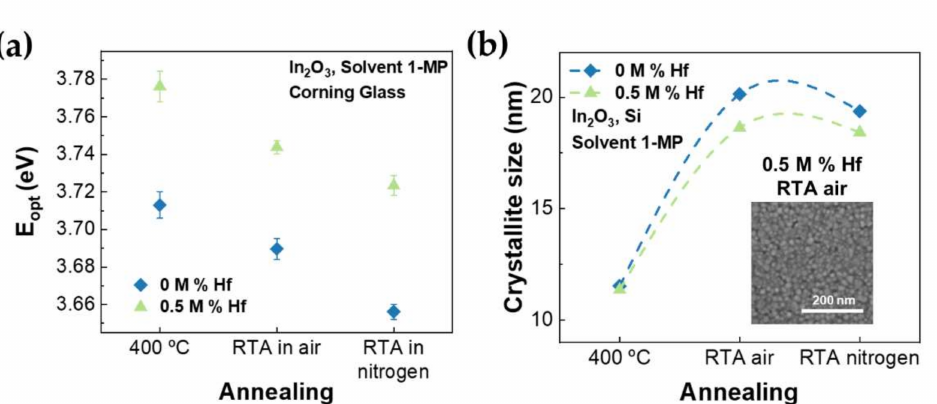
Figure 5. ( a ) Optical bandgap (eV) and ( b ) crystallite size (nm) of undoped and Hf-doped In 2 O 3 thin films with different annealing conditions; inset shows the SEM surface image of 0.5 M% Hf-doped In 2 O 3 rapid thermally annealed in air for 10 min at 600 ◦